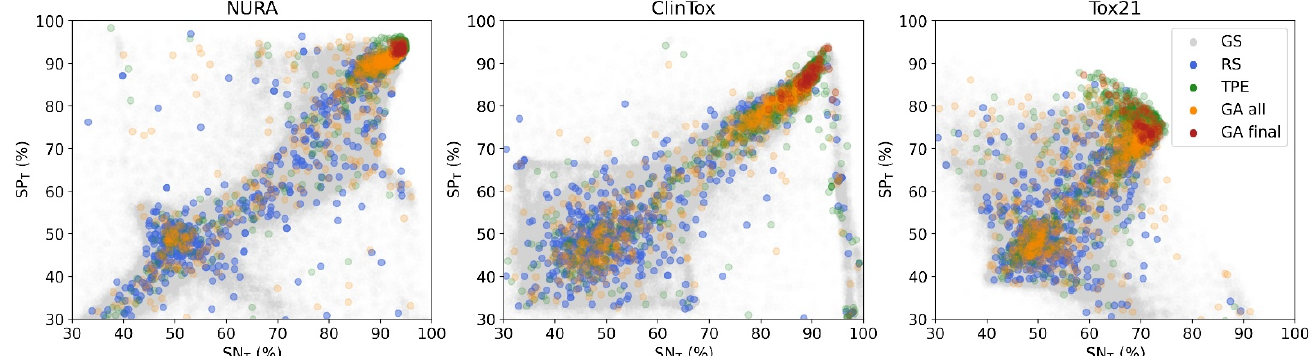
Figure 3. Sensitivity (SN T ) vs. specificity (SP T ) for the three datasets with 3-fold cross validation. Each point represents an architecture found by grid search (GS, grey points), random search (RS, light blue points), tree-structured Parzen estimator (TPE, green points), all tested architectures by genetic algorithms (GA, orange points) and architectures in the final GA populations (red points).